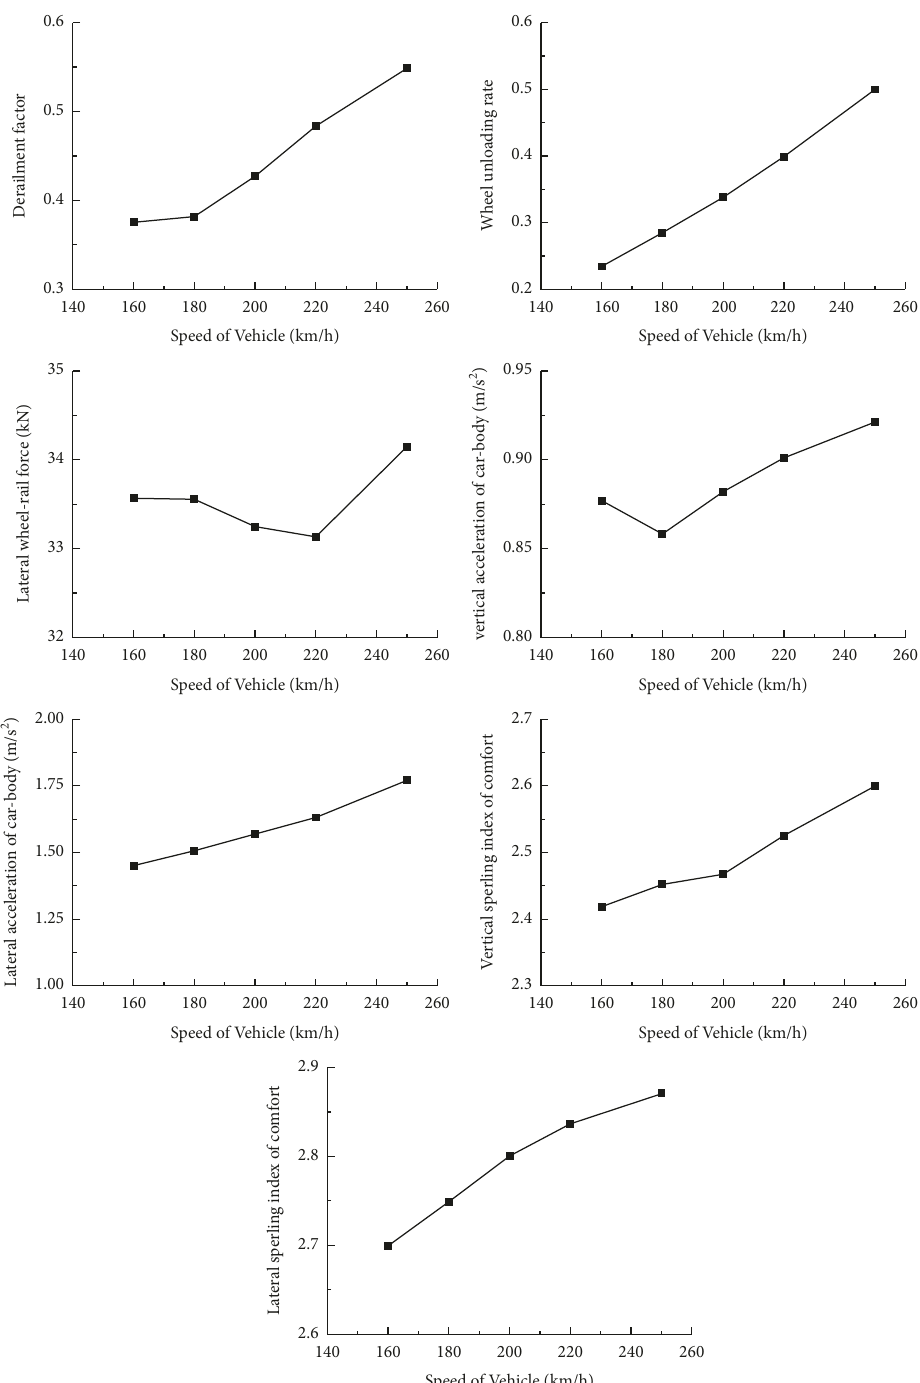
Figure 15: The maximum value of evaluation indexes of the vehicle with different speed in Case